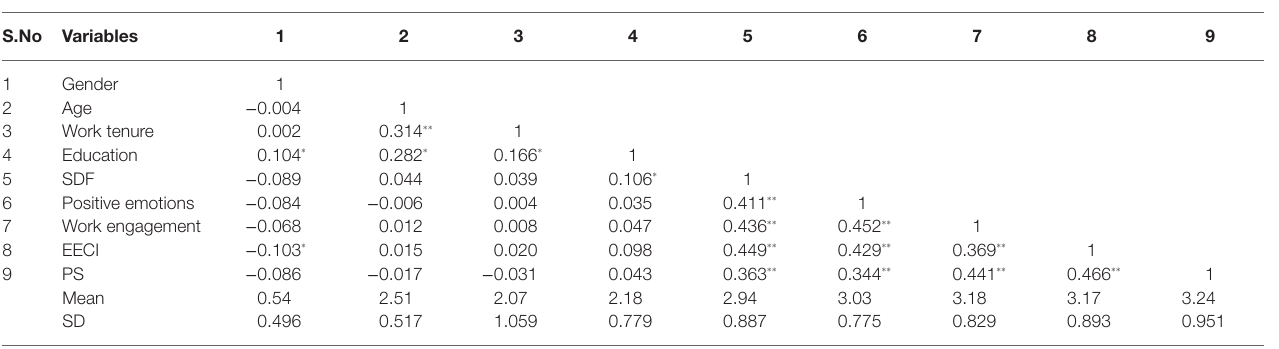
TABLE 4 | Descriptive analysis and correlations among variables.